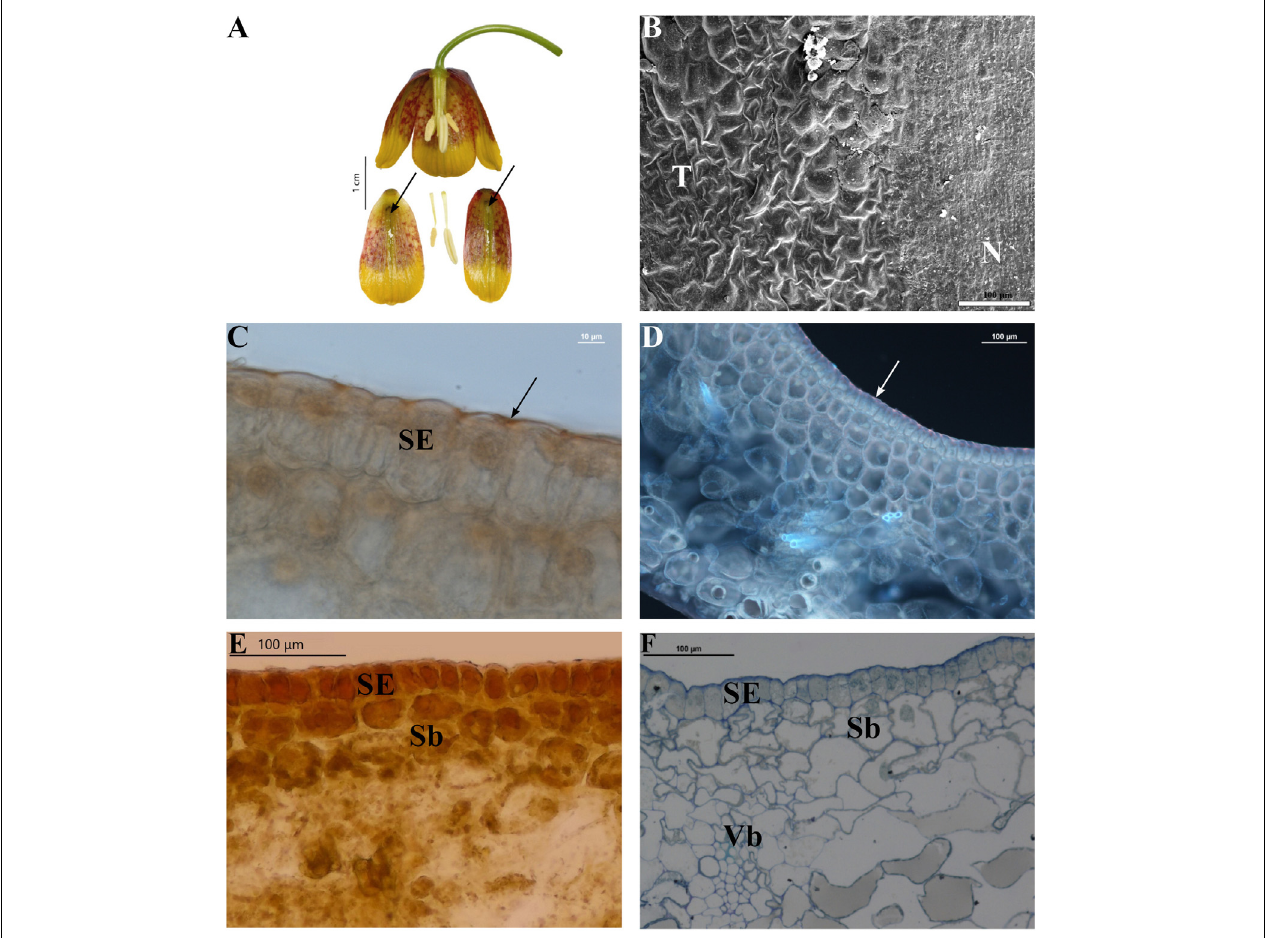
FIGURE 3 | Flowers and nectaries of F. michailovskyi at full anthesis. Macro, SEM, and LM images. (A) Flowers and tepals, nectaries marked with arrows. (B) Part of outer tepal showing flat nectary cells (N) and slightly convex cells of surrounding tepals area (T). (C) Cuticule on the surface of secretory epidermis (SE) of outer tepals stained with Sudan IV, arrow indicates lipids layer on the surface of cuticule of nectary. (D) Staining with aniline blue does not reveal the presence of callose in the walls of nectary cells. Arrow indicates lipids on the cuticle of the nectary of outer tepals. (E) Treatment with Lugol’s iodine solution reveals the absence of starch in secretory (SE) and subsecretory parenchyma (Sb). Secretory epidermis with dense cytoplasm. (F) Staining with Azure II showing secretory epidermis (SE), subsecretory parenchyma (Sb), and ground parenchyma with vascular bundle